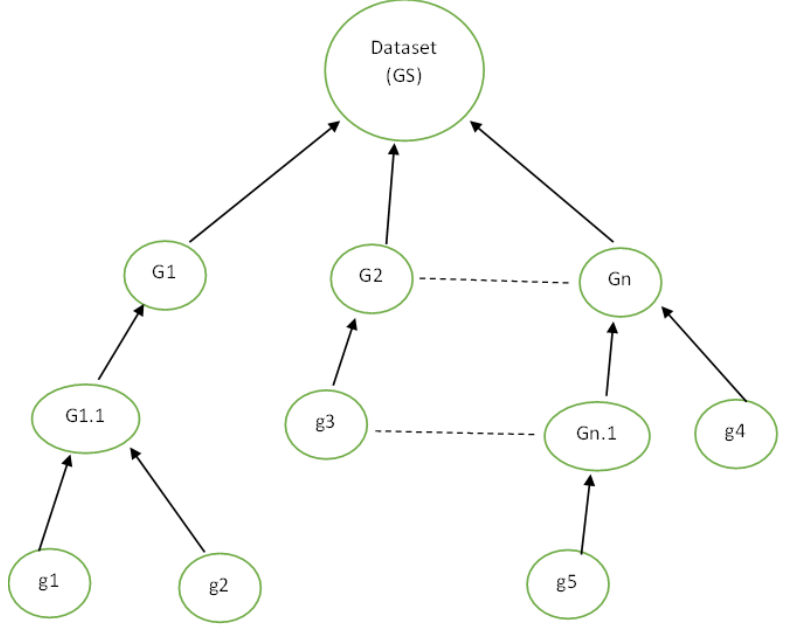
Figure 2. Granular Computing Network